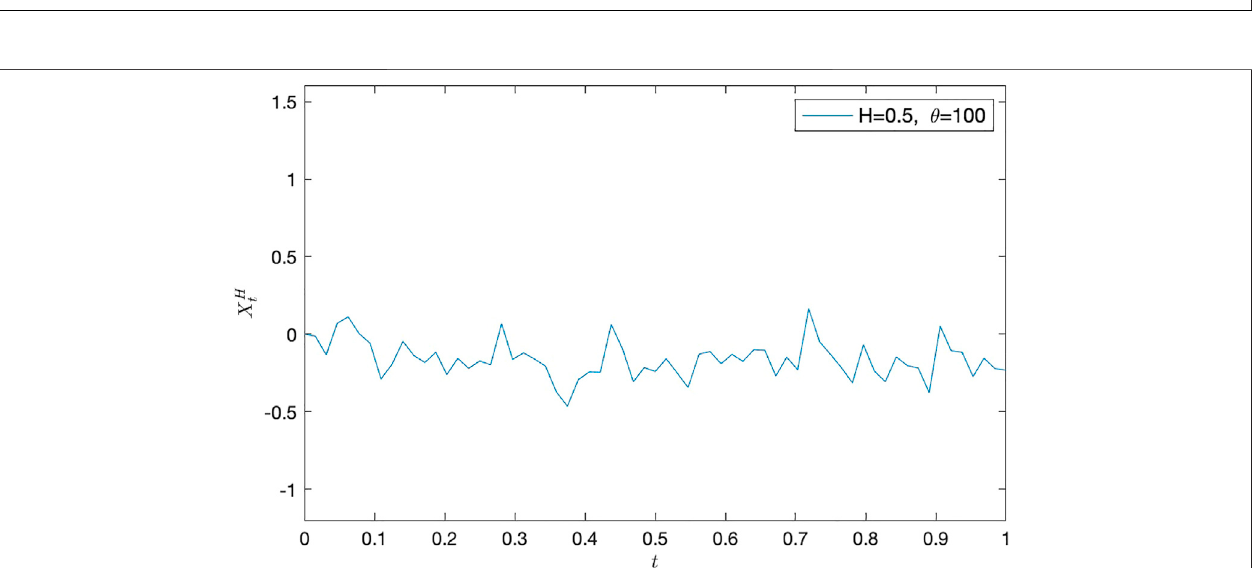
FIGURE 6 | Path of X H with θ (cid:1) 100 and H (cid:1) 0.5.